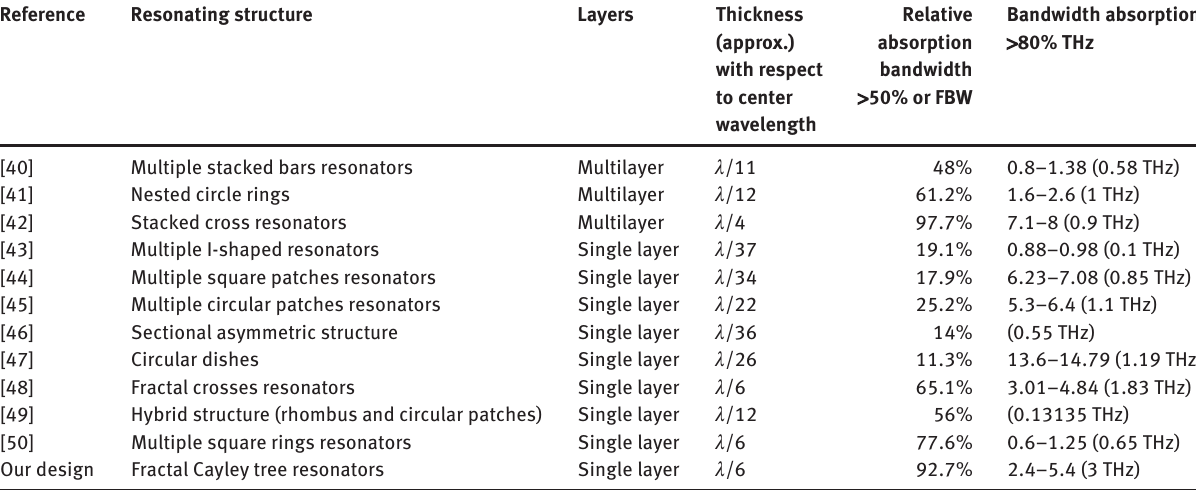
Table 1: Absorption performances of recently reported THz broadband, multilayer and single-layer MM absorbers.